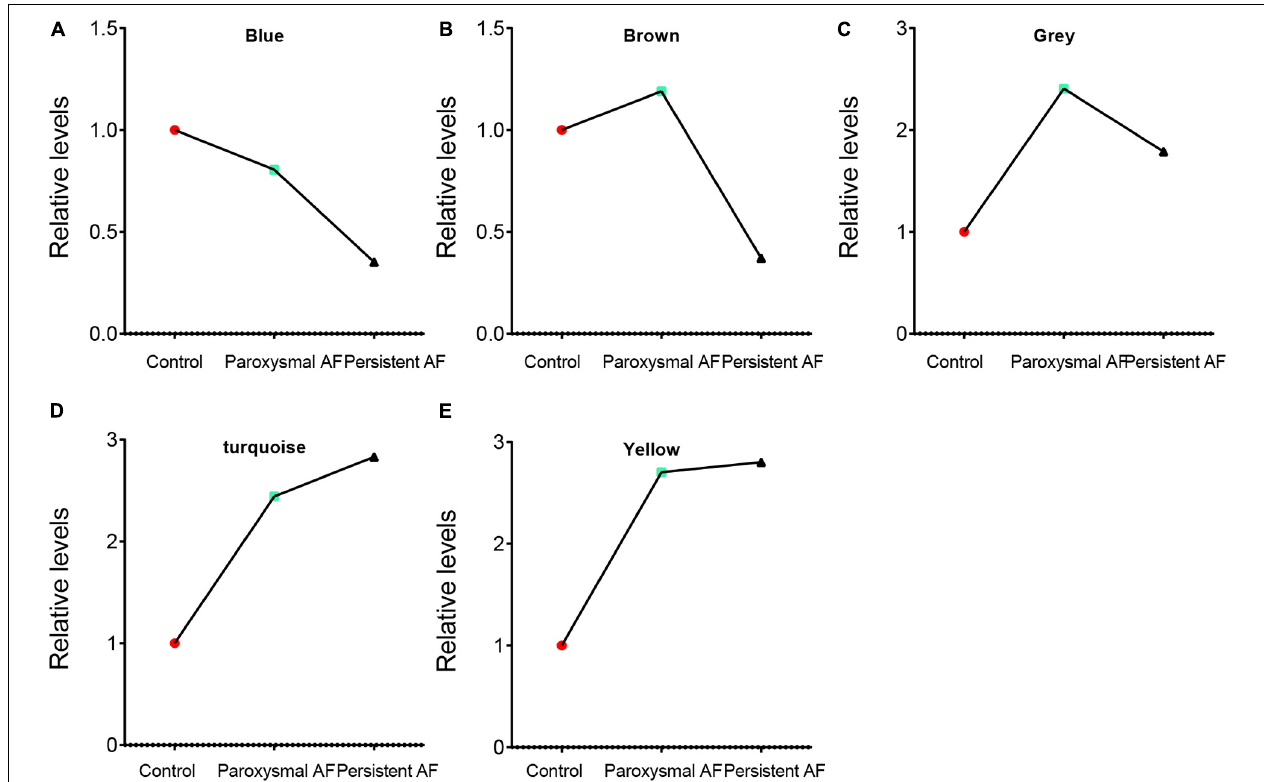
FIGURE 5 | The analysis of the correlation between AF progression and module expression. (A–E) The analysis of the correlation between AF progression and the average expression of genes in blue module (A) , brown module (B) , grey module (C) , turquoise module (D) , and yellow module (E)